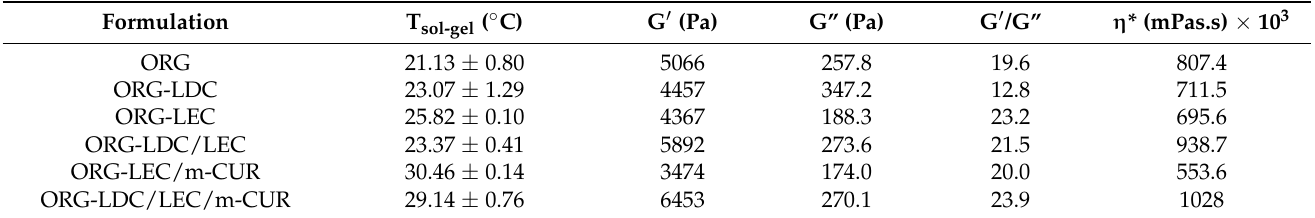
Table 3. Rheological parameters: sol–gel transition temperature (T sol-gel , G (cid:48) (elastic) and G” (viscous) moduli, and viscosity ( η *) at 32.5 ◦ C for the PL407 + IPM ORG formulations.